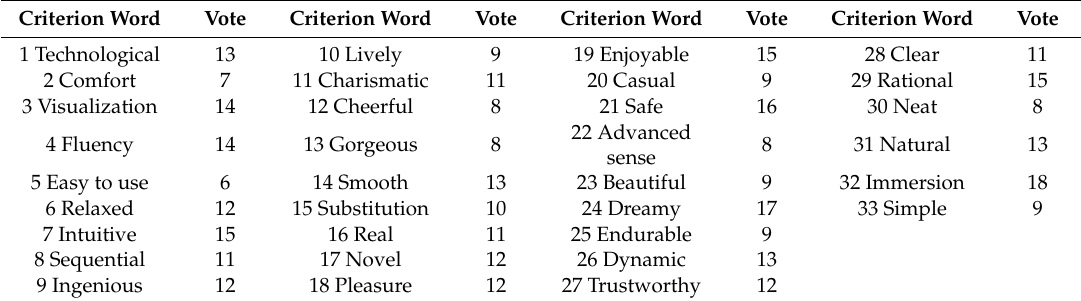
Table 3. Criterion word set.